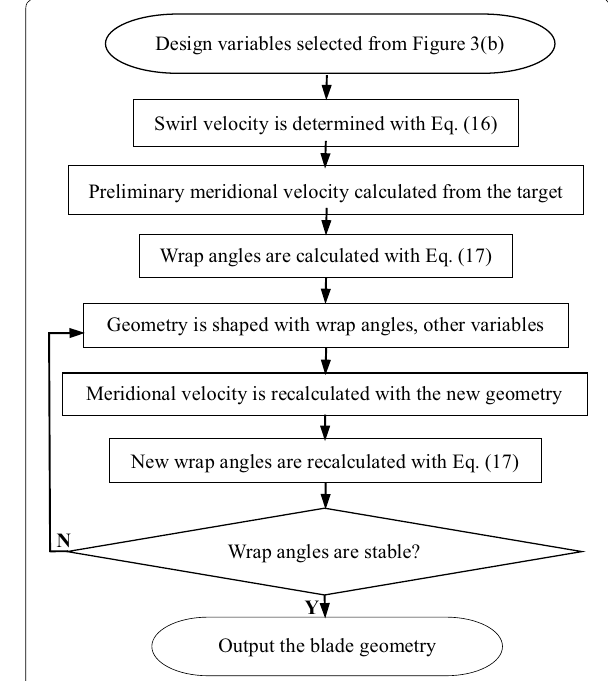
Figure 4 Flow chart of the modified design